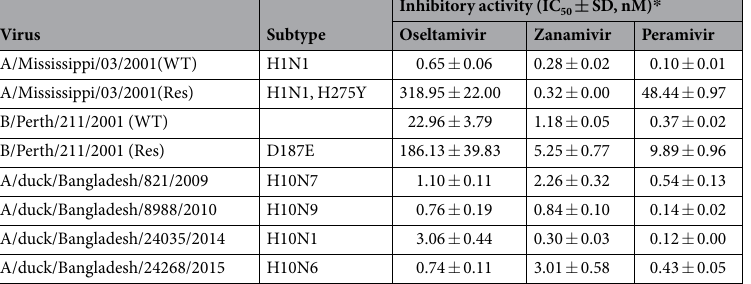
Table 4. Susceptibility of H10 AIVs from Bangladeshi LPMs to NA inhibitors. WT, wild-type virus; Res, control virus resistant to NA inhibitors. * Inhibitory concentration (IC 50 ) value is the concentration that inhibits viral NA activity by 50%. IC 50 values are expressed as the mean ± SD